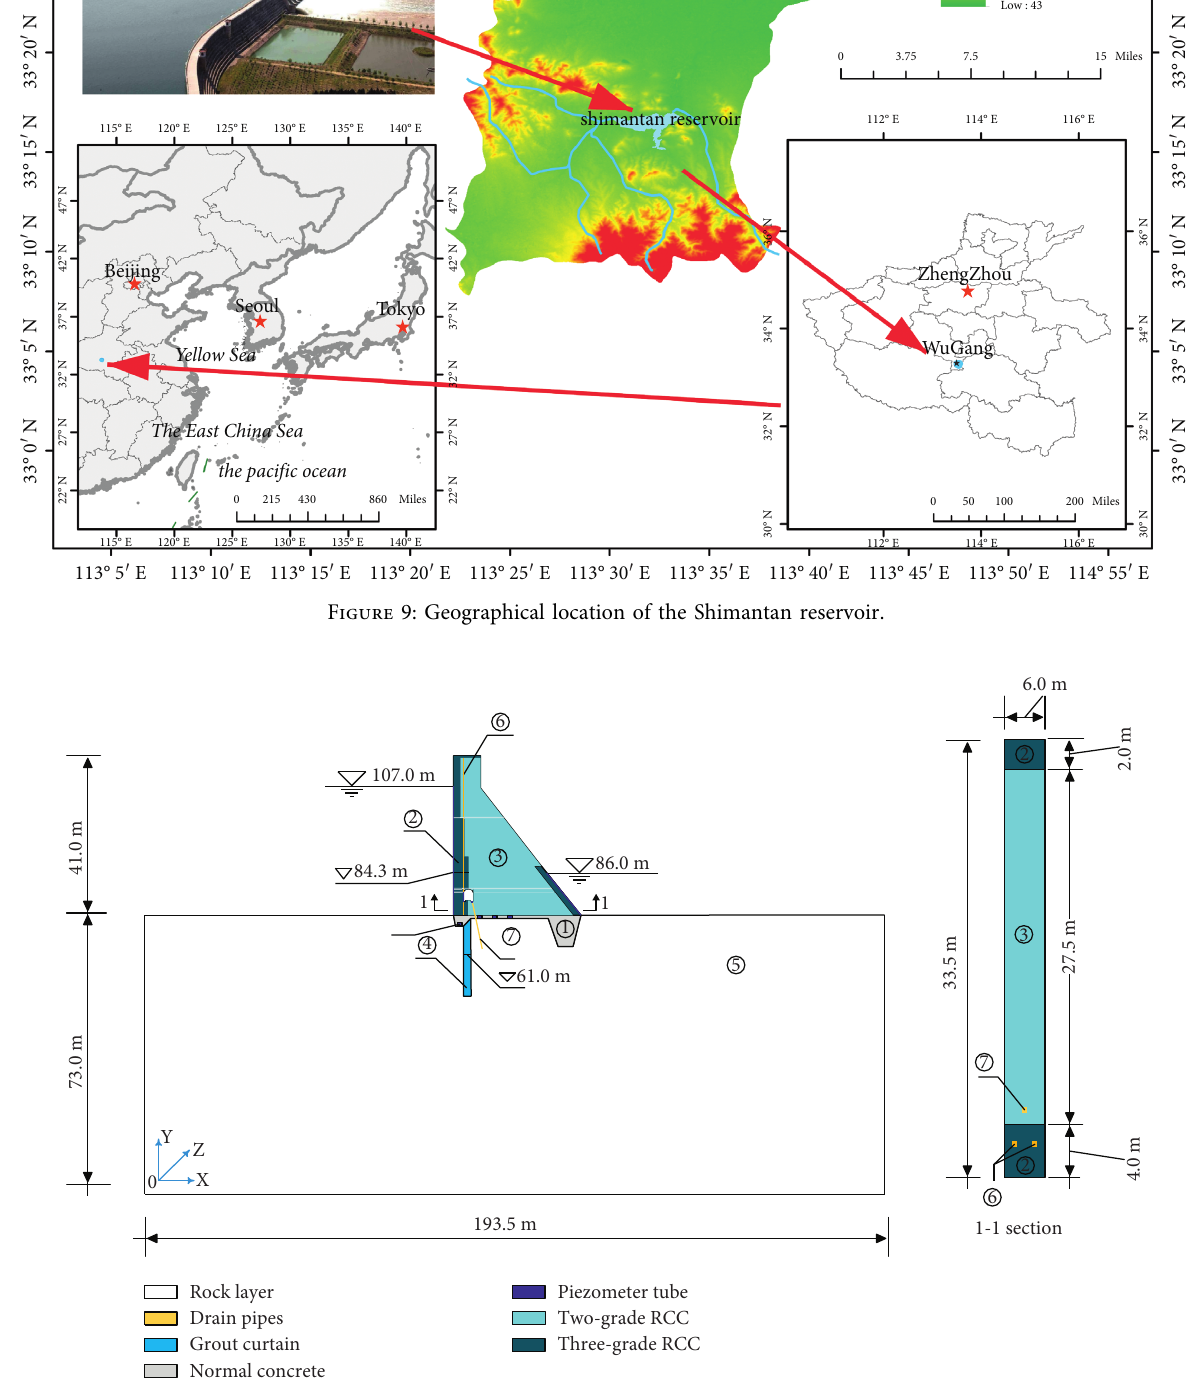
Figure 10: Overall layout and profile of the Shimantan reservoir.